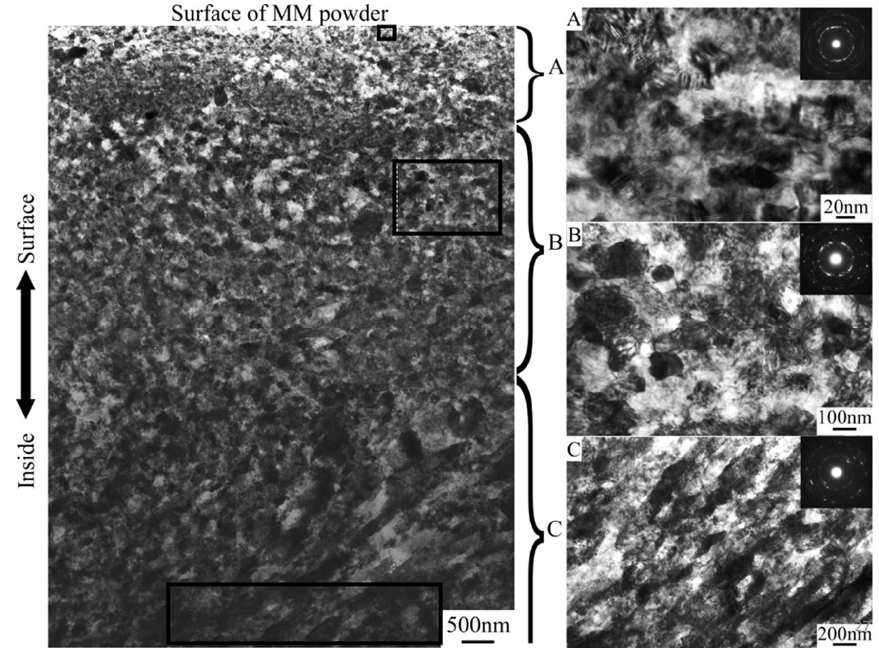
Figure 5. TEM micrographs of the shell area of milled pure Ti powder. Enlargement of rectangular areas of ( A ), ( B ) and ( C ) are separately presented.